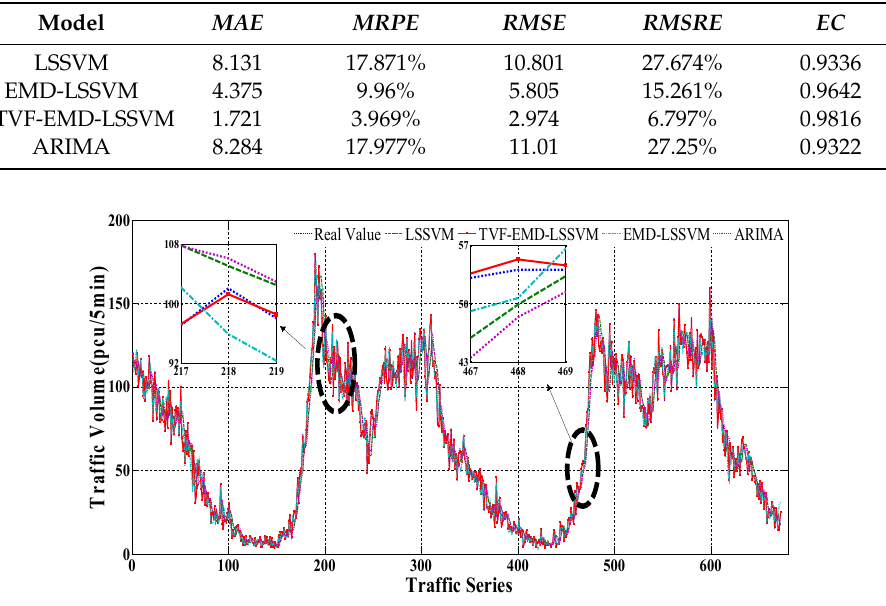
Figure 5. The predictions of different methods (A) .